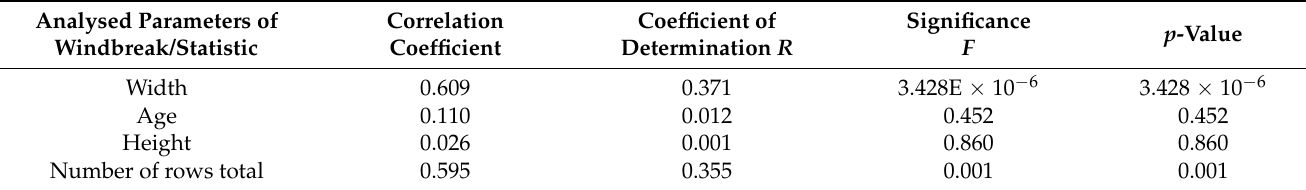
Table 6. Regression analysis of the relationship of basic wind parameters to the overall point evaluation. Analysed Parameters of